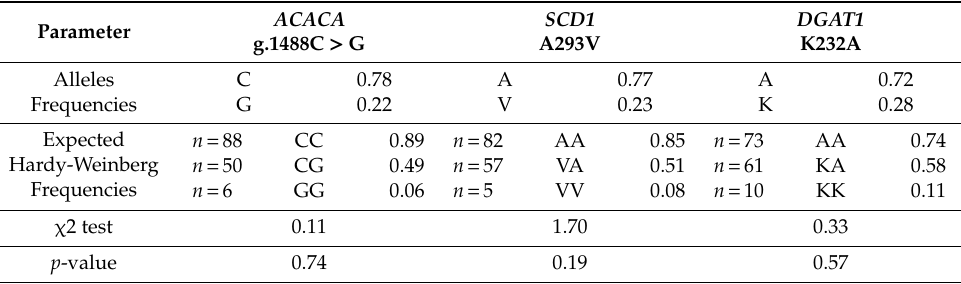
Table 1. Allele and genotype frequencies of AJ312201.1g.1488C > G (g.1488C > G) single nucleotide polymorphism (SNP) in acetyl-CoA carboxylase α ( ACACA ) gene, A293V SNP in stearoyl-CoA